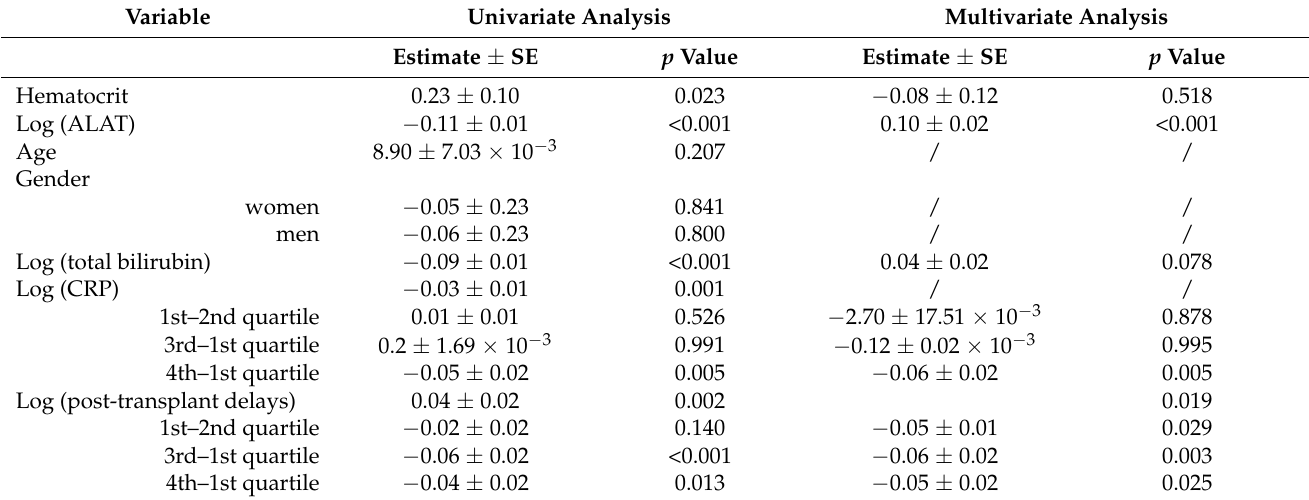
Table 3. Univariate and multivariate linear mixed-effect regression analyses for the identification of the determinants of tacrolimus overexposure (tacrolimus trough concentrations > 15 µ g/L ( n = 91)) during longitudinal therapeutic drug monitoring.